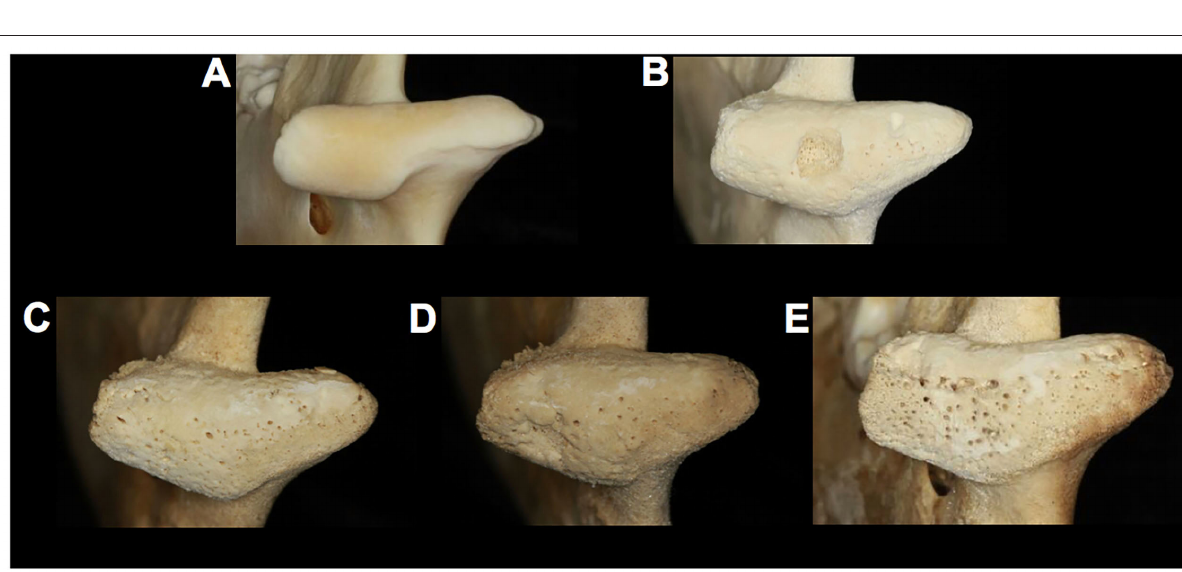
Frontiers in Veterinary Science |